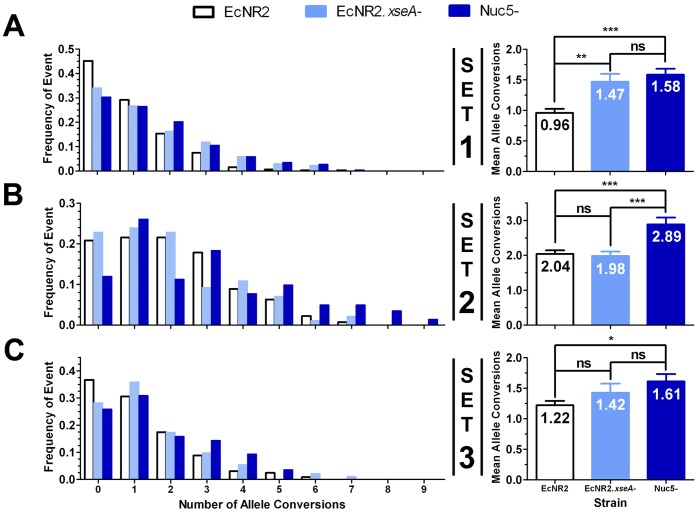
Effect of Nuclease Genotype on CoS-MAGE Performance.CoS-MAGE was carried out in three strains (EcNR2, EcNR2.xseA
−, and nuc5−), using sets of ten oligos encoding TAGTAA mutations, and a co-selection oligo designed to revert a mutated selectable marker located within 500 kb of the targeted loci. Set 1 (A) was co-selected with chloramphenicol acetyltransferase (cat, inserted at the mutS locus). In comparison with EcNR2 (n = 319), both EcNR2.xseA
− (**p = 0.0001, n = 135) and nuc5− (***p<0.0001, n = 257) show statistically significant increases in mean oligo conversion, a decreased proportion of clones exhibiting no allele conversions, and more clones with 5+ conversions. Set 2 (B) was co-selected with beta lactamase (bla, inserted with the λ prophage). Here, nuc5− (n = 142) shows a statistically significant increase in recombineering performance compared to both EcNR2 (***p<0.0001, n = 268) and EcNR2.xseA
− (***p<0.0001, n = 184). Set 3 (C) was co-selected with tolC. Here, nuc5− (n = 139) shows a statistically significant increase in mean allele conversion compared to EcNR2 (*p = 0.002, n = 327). EcNR2.xseA
− (n = 92) shows an intermediate phenotype between EcNR2 (p = 0.2) and nuc5- (p = 0.3). All oligos used in this experiment had two PT bonds on both ends. Data shown in the right panels are presented as the mean with the standard error of the mean. Statistical significance is denoted using a starred system where ns denotes a non-significant variation, * denotes p<0.003, ** denotes p<0.001, and *** denotes p<0.0001.